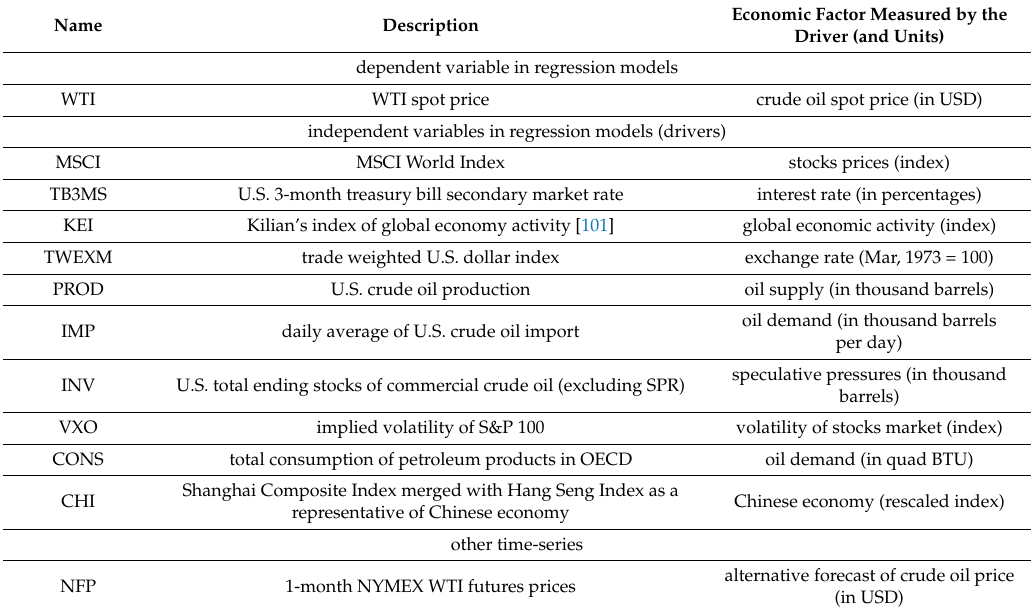
Table 1. Description of time-series